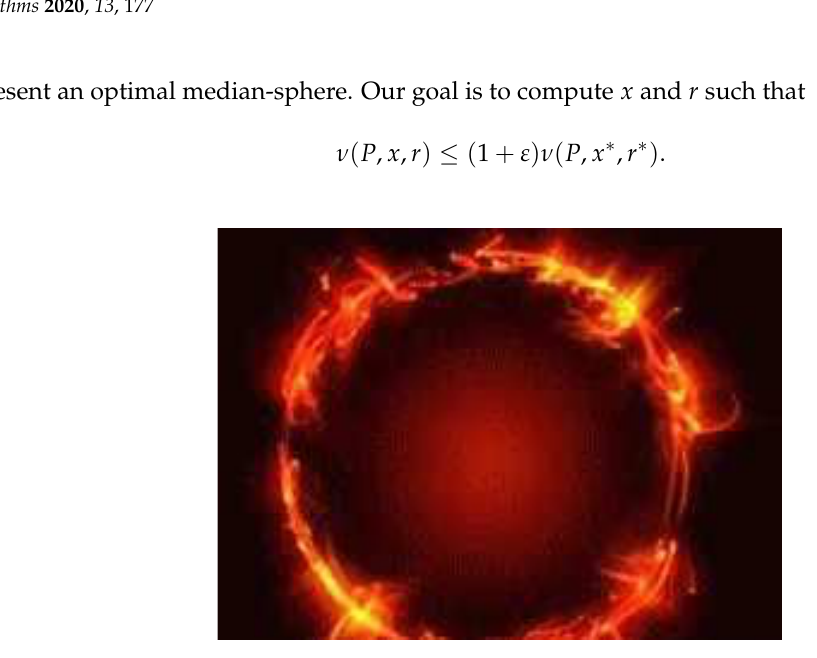
Figure 1. An RGB image that captured a flame of fire [12]. The goal is to approximate the center of the flaming